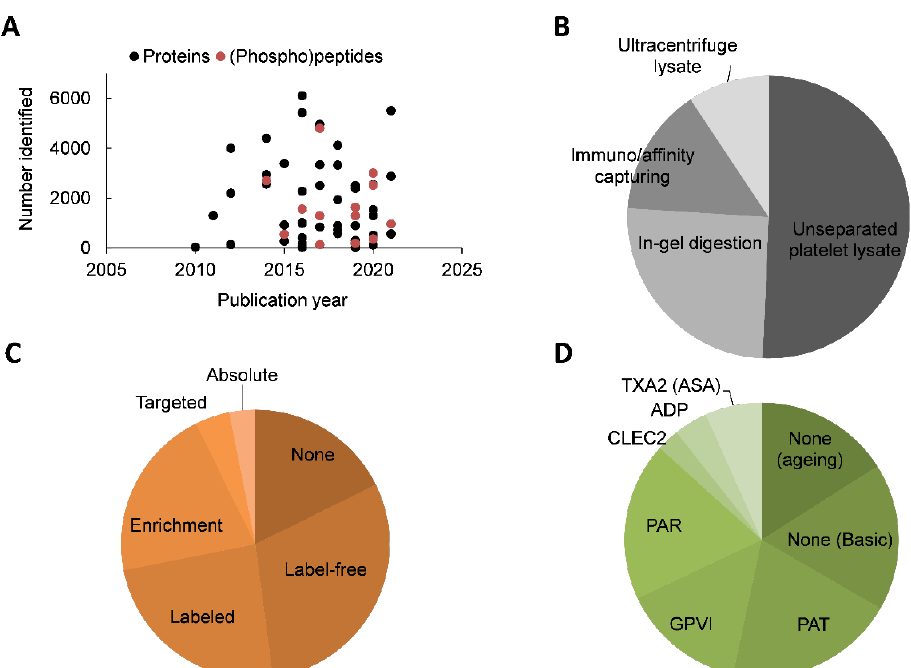
Figure 1. Overview of 67 platelet proteomic publications. ( A ), Numbers of identified proteins and (phospho)peptides in human platelets in publications over the years. ( B ), Distribution profile of proteomic papers for types of platelet preparations. Half of the collected papers (49%) used trypsin treatment of unseparated platelet lysates; others used prior separation by gel electrophoresis and in-gel digestion (26%), immuno/affinity capturing (15%) or ultracentrifugation enrichment (9%). ( C ), Distribution profile of proteomic quantification type. In 67 publications, 20% used no other method, 23% used stable isotope labelling, 30% used label-free quantification, 22% employed special peptides enrichments and 5% employed targeted (4%) or absolute quantification (1%) methods. ( D ), Distribution profile of type of (stimulated) platelets used in 67 publications. Most papers used healthy donor platelets without agonist (33%), patient platelets (PAT, 20%) or platelets stimulated via GPVI (15%) or PARs (17%). Rarer was analysis of platelets stimulated via CLEC-2 (3%), ADP (4%) or TXA 2 /aspirin